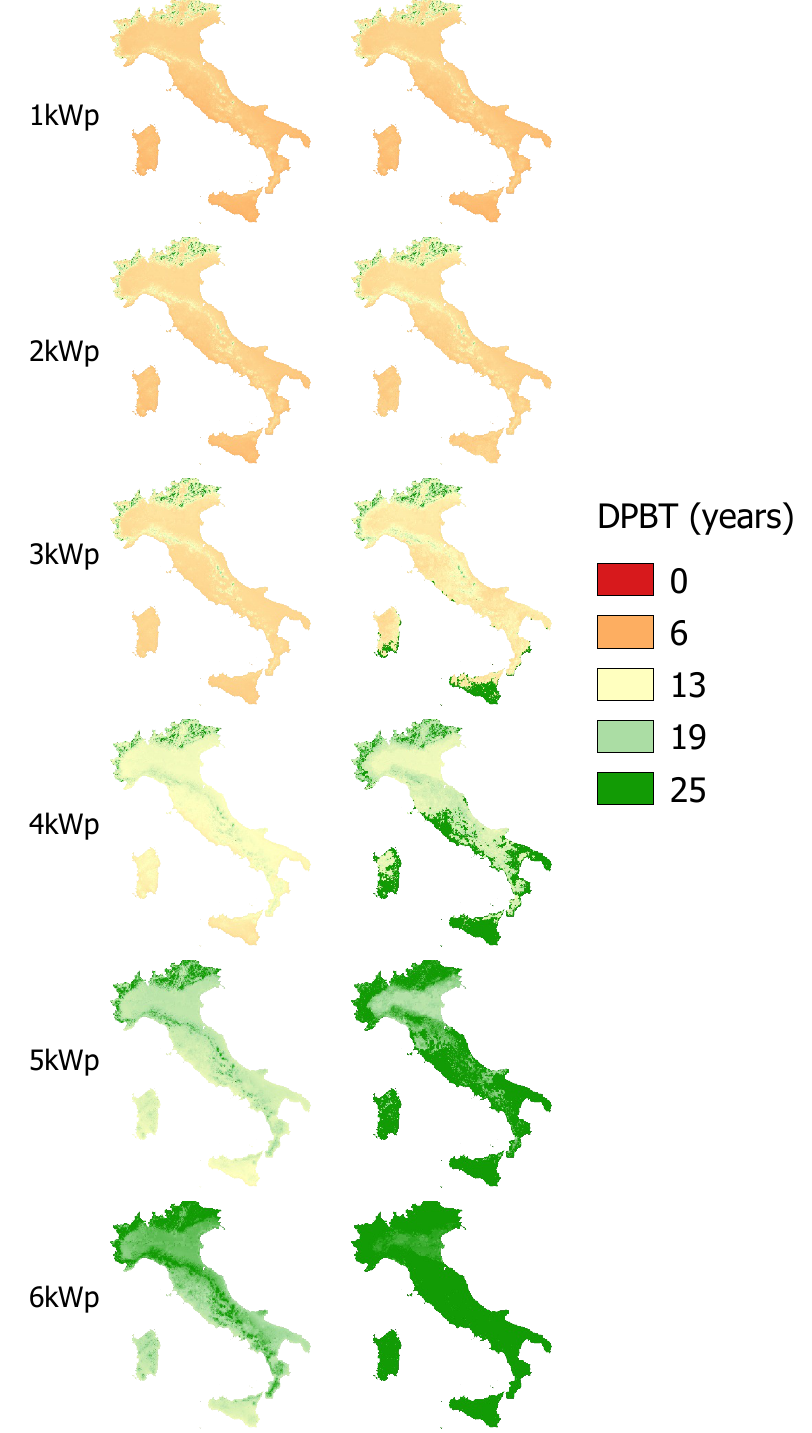
Figure A14. DPBT for E L = 4000 kWh, left side without battery and right side with